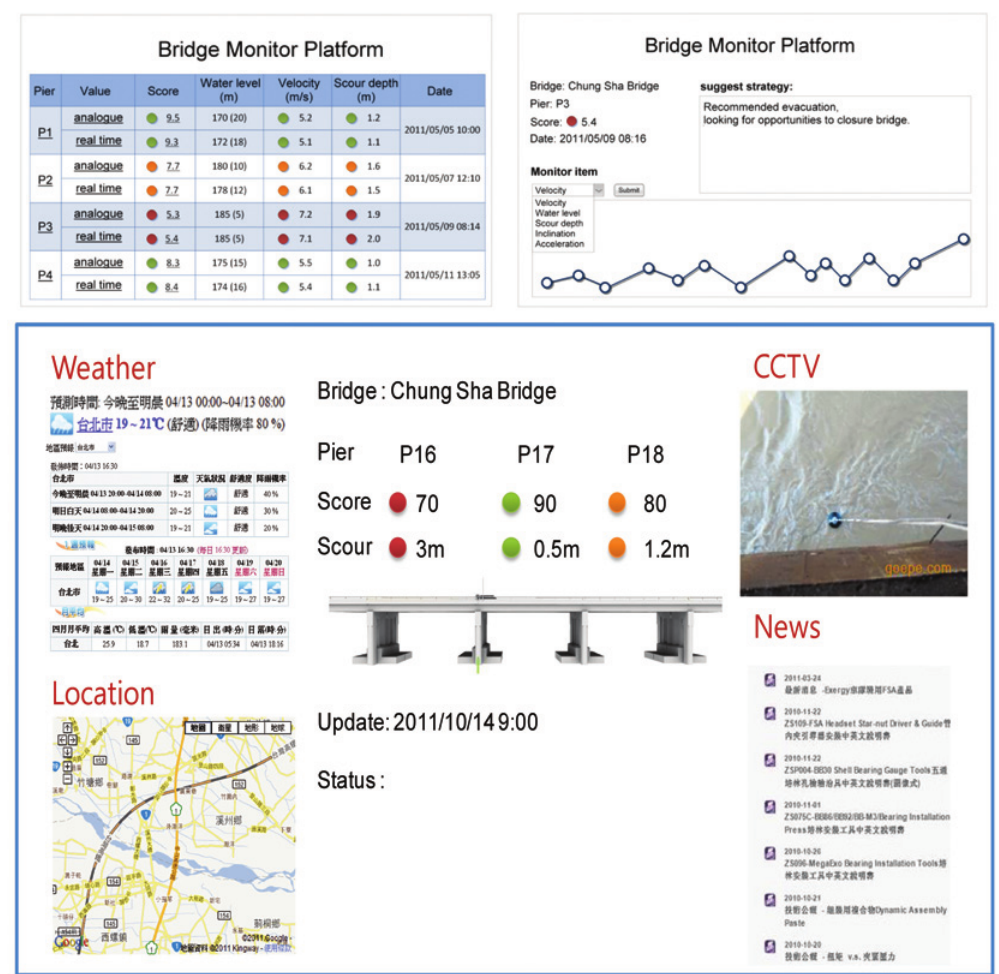
Fig. 8. The platforms of web-based bridge scour monitoring